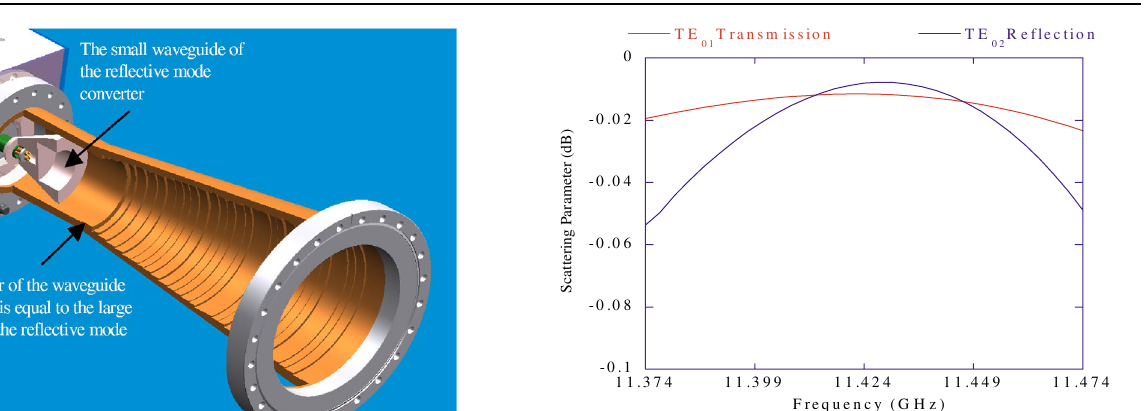
taper.FIG. 4. (Color) End taper and mode converter. The movable cup at the end of the taper reflects the TE mode, and vice versa.